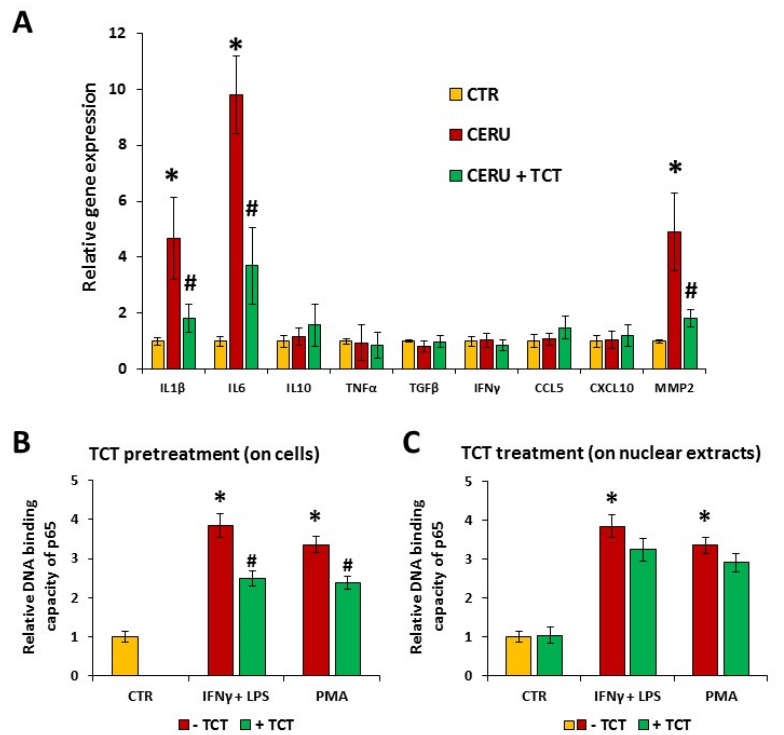
Figure 2. Tricetin reduces the expression of IL1 β , IL6, and MMP2 genes, and inhibits NF κ B activation in primary pancreatic acinar cells. Primary acinar cells were pretreated with 30 μ M tricetin (TCT) or medium for one hour followed by 100 nM cerulein treatment. After 24 h, mRNA levels were measured with RT-qPCR. Error bars represent the SD of five (or three in the cases of CCL5 and CXCL10) independent experiments. Stars (*) indicate significant ( p < 0.05) differences between cerulein-treated cells versus control. Hashtags (#) indicate significantly ( p < 0.05) reduced gene expression by TCT versus the cerulein-treated group ( A ). Primary acinar cells were pretreated with 30 µ M TCT or medium for one hour followed by 20 ng/mL mIFN γ + 1 µ g/mL LPS, or 1 µ M PMA treatment for one hour. Nuclear fractions were extracted from the cells and were used in NF κ B p65 binding assays as described in the Materials and Methods section ( B ). Part of the nuclear fractions were treated with 30 µ M TCT to investigate the effect of TCT on the DNA binding of NF κ B ( C ). Statistical analysis was performed with one-way (panel ( A )) or two-way (panels ( B , C )) ANOVA test followed by Tukey’s post hoc